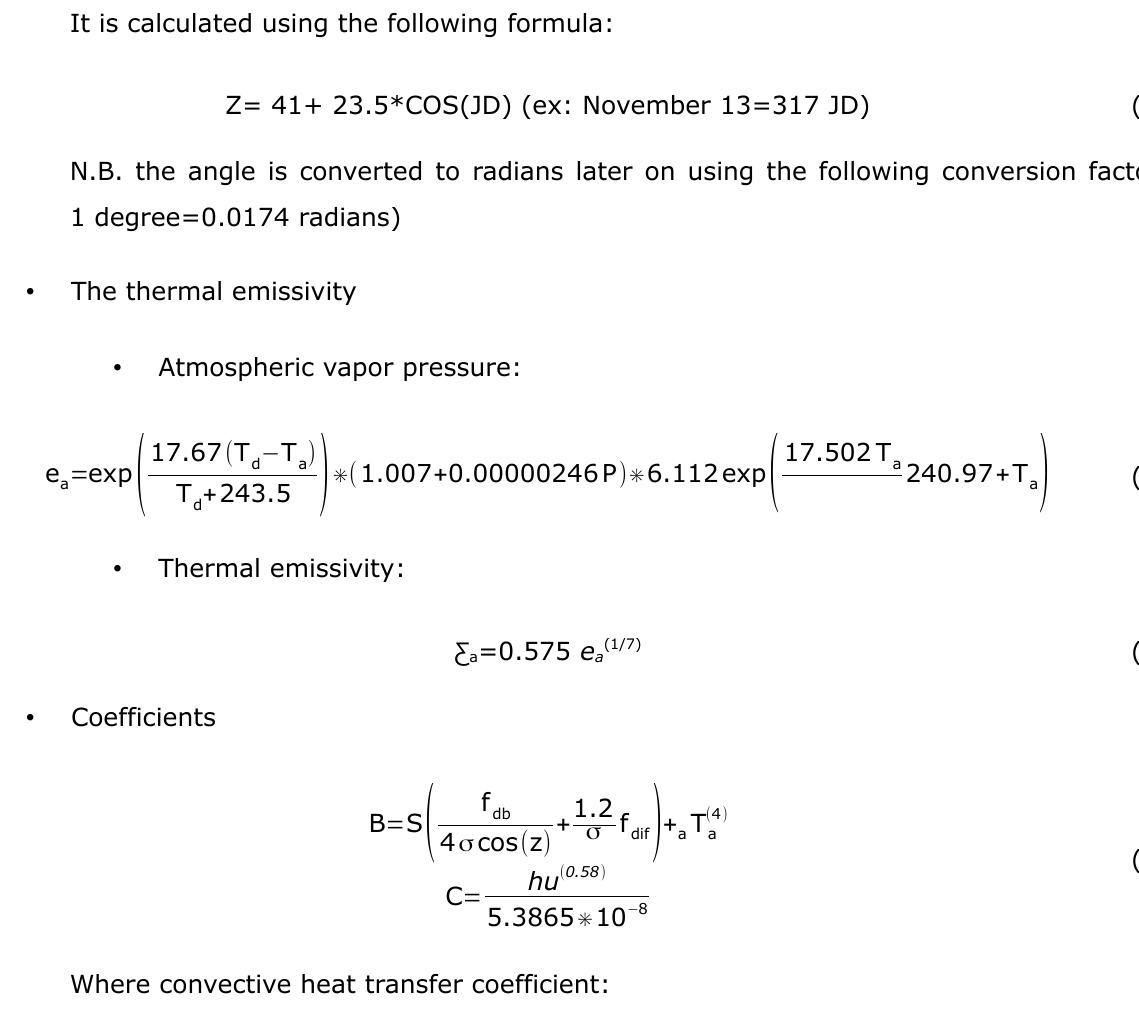
Table 6. Solar irradiance